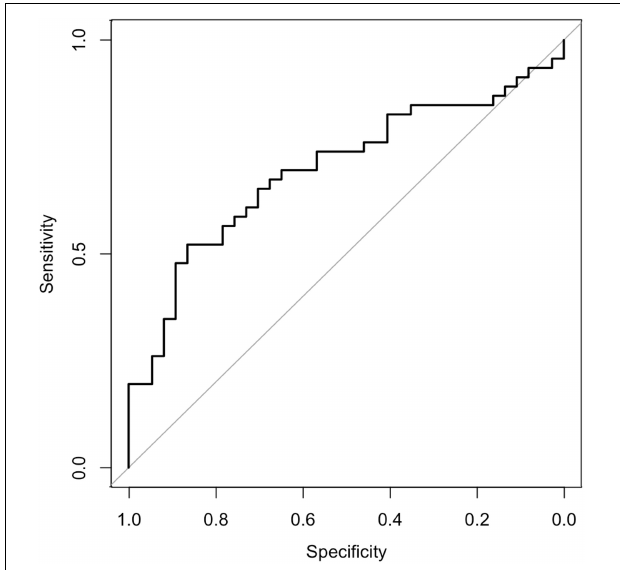
FIGURE 2 | Receiver operating characteristic curve. The area under the receiver operating characteristic curve was 0.696 (95% confidence interval: 0.582–0.81).